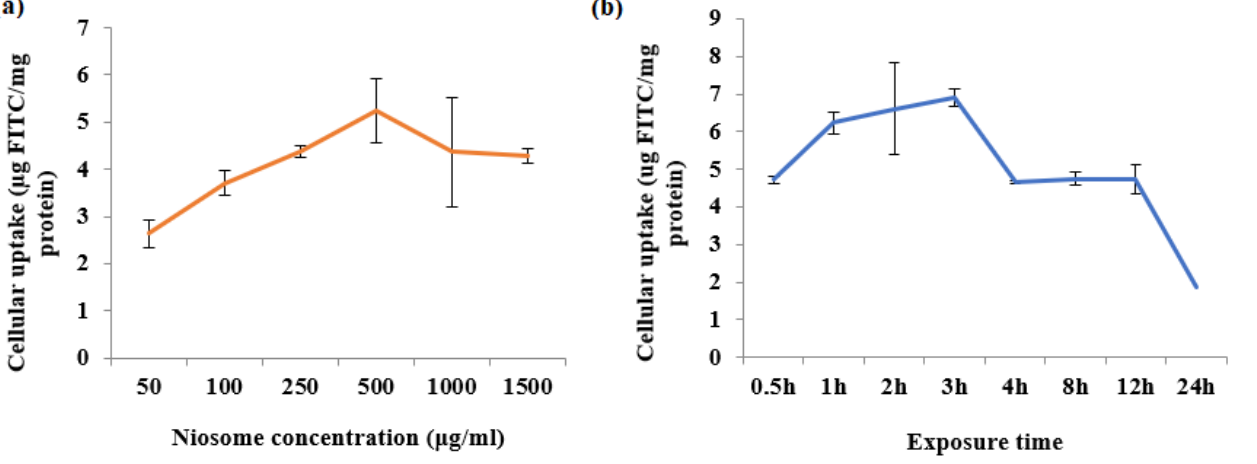
Figure 8. ( a ) Effects of niosome concentrations and ( b ) duration of exposure on the uptake of vesicles by Fbs.